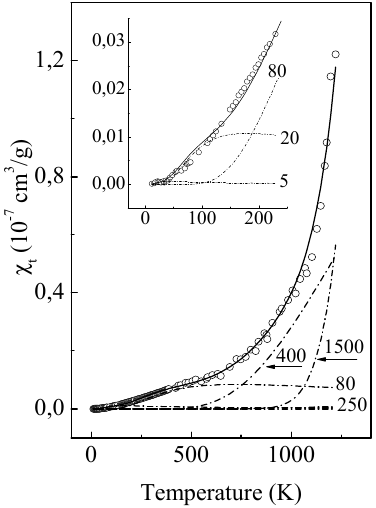
Figure 8. Temperature-dependent part of the magnetic susceptibility of the ordered Al 63 Cu 25 Fe 12 phase: (o), experimental results [2]; and solid line, description of the results by a sum of the magnetic elementary terms (dash-dotted lines) with δ E = 5, 16, 80, 260, 400, and 1500 meV, respectively.